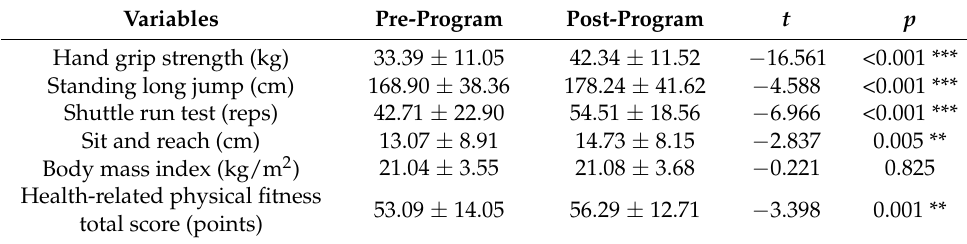
Table 2. Changes in physical fitness variables after school-based physical activity